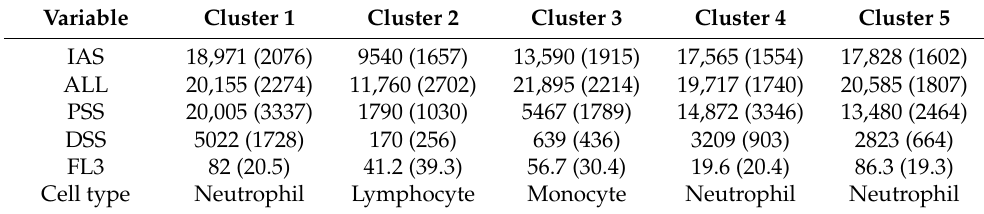
Figure 1. ALL versus PSS, colorized according to the K-means clustering with 5 clusters. Cluster 1 (blue), 4 (red), and 5 (violet) are corresponding to different populations of neutrophils. Clusters 2 (orange) and 3 (green) describe lymphocytes and monocytes, respectively. Table 2. Mean (SD) (AU) for each variable and predominant cell type in each